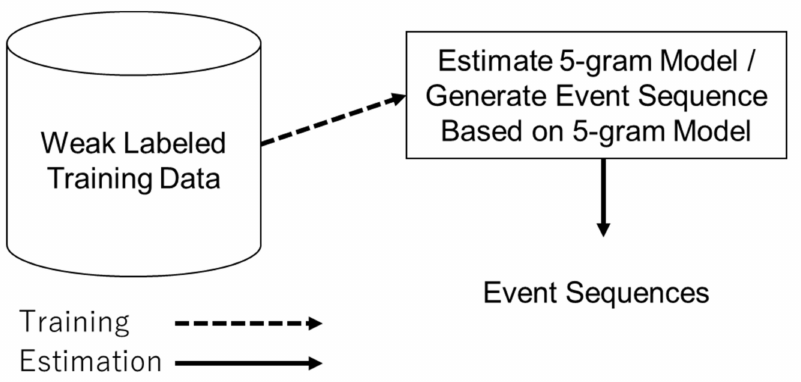
Figure 7. The 5-gram based event sequence augmentation.